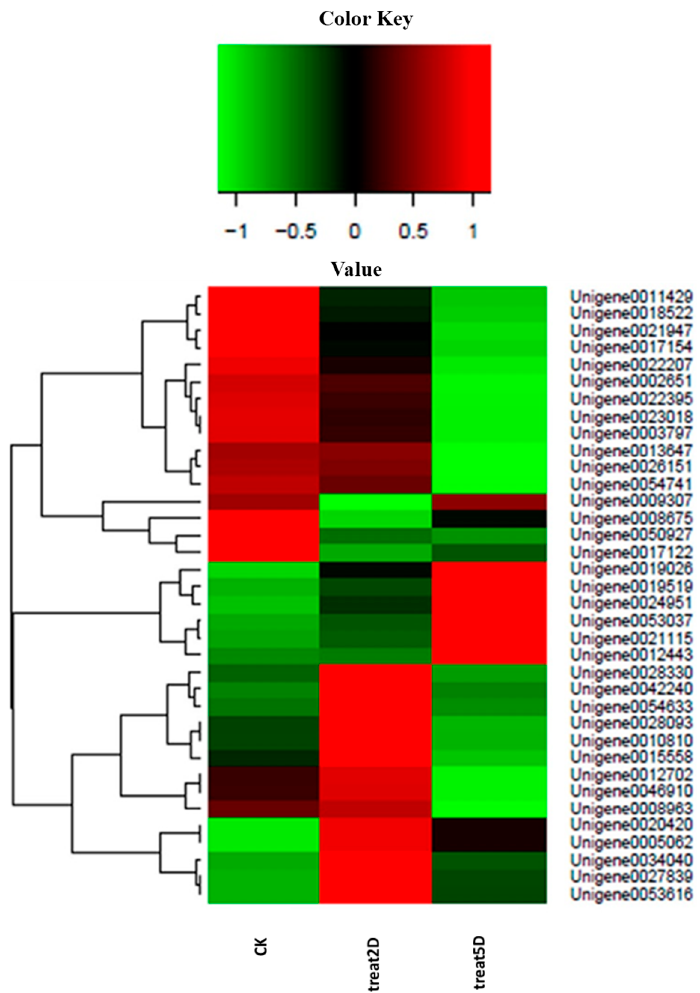
Figure 5. Differential expression of genes related with terms in the P. citri STEM. Each column represents an experimental sample (e.g., CK, 2D and 5D), and each row represents a gene. Differences in expression are shown in different colors. Red indicates high expression, and green indicates low expression.